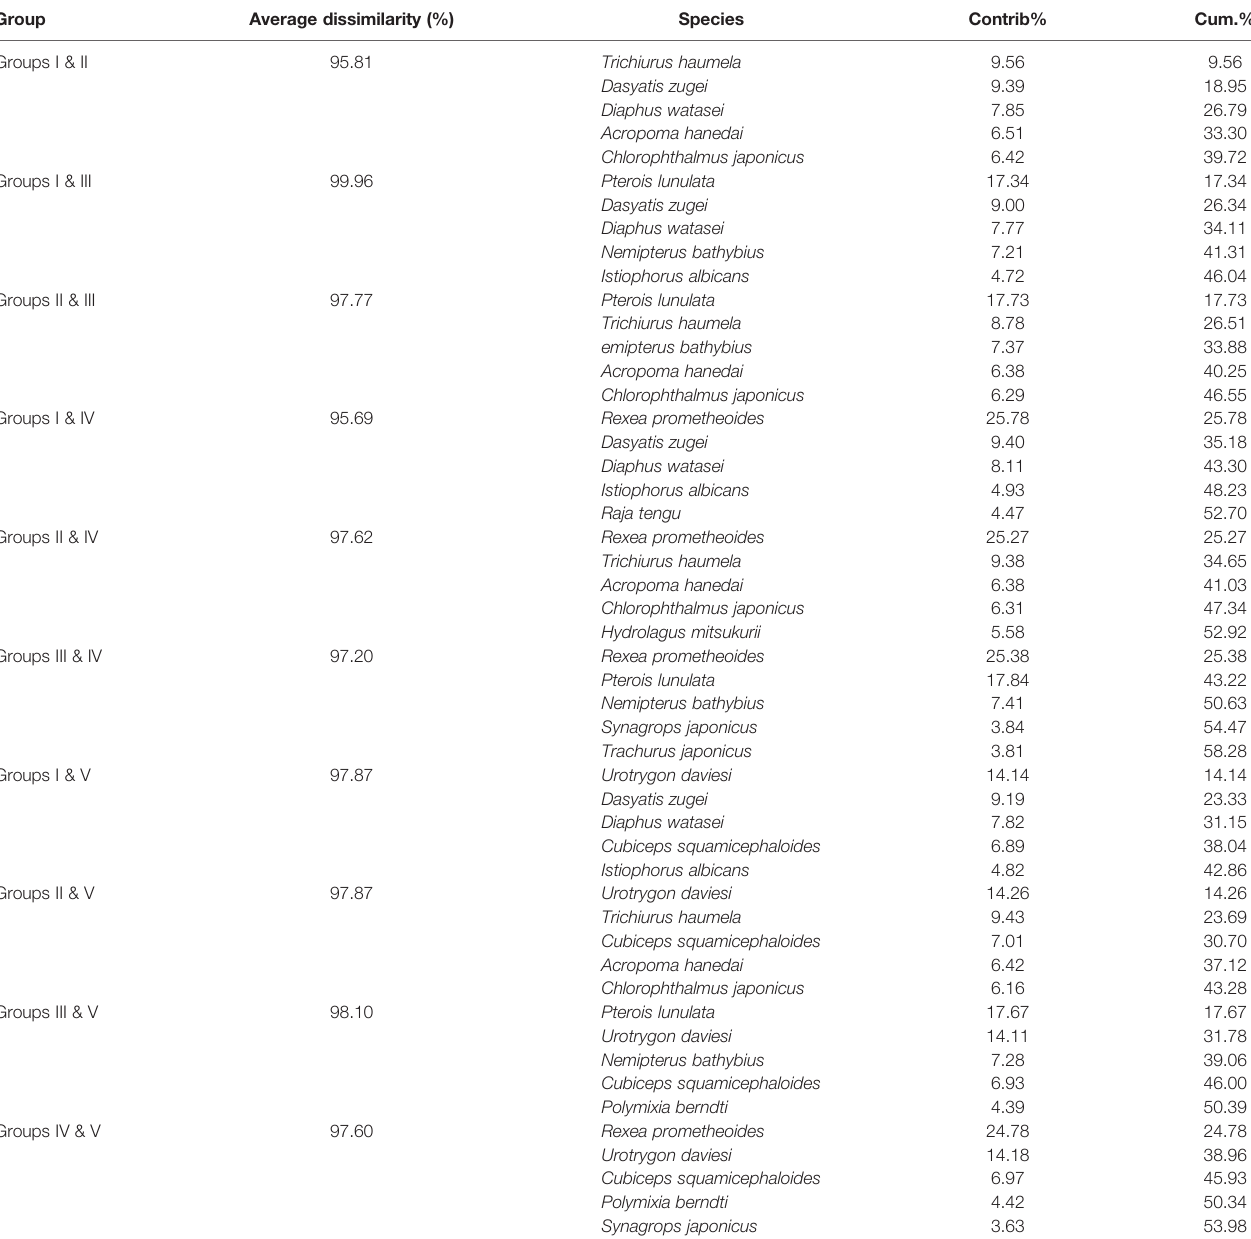
TABLE 3 | Average dissimilarity and top fi ve discriminating species among group I, II, III, IV and V over the NCSSCS. Group Average dissimilarity (%) Species Contrib% Cum.% Groups I &